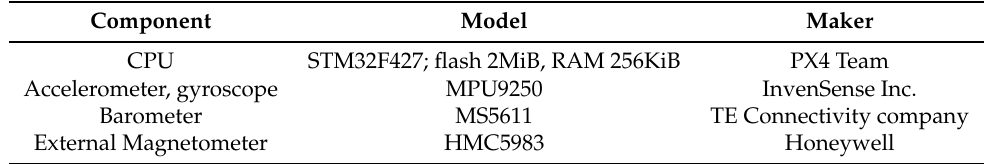
Table 4. Composition of flight control unit, Pixhawk v2.